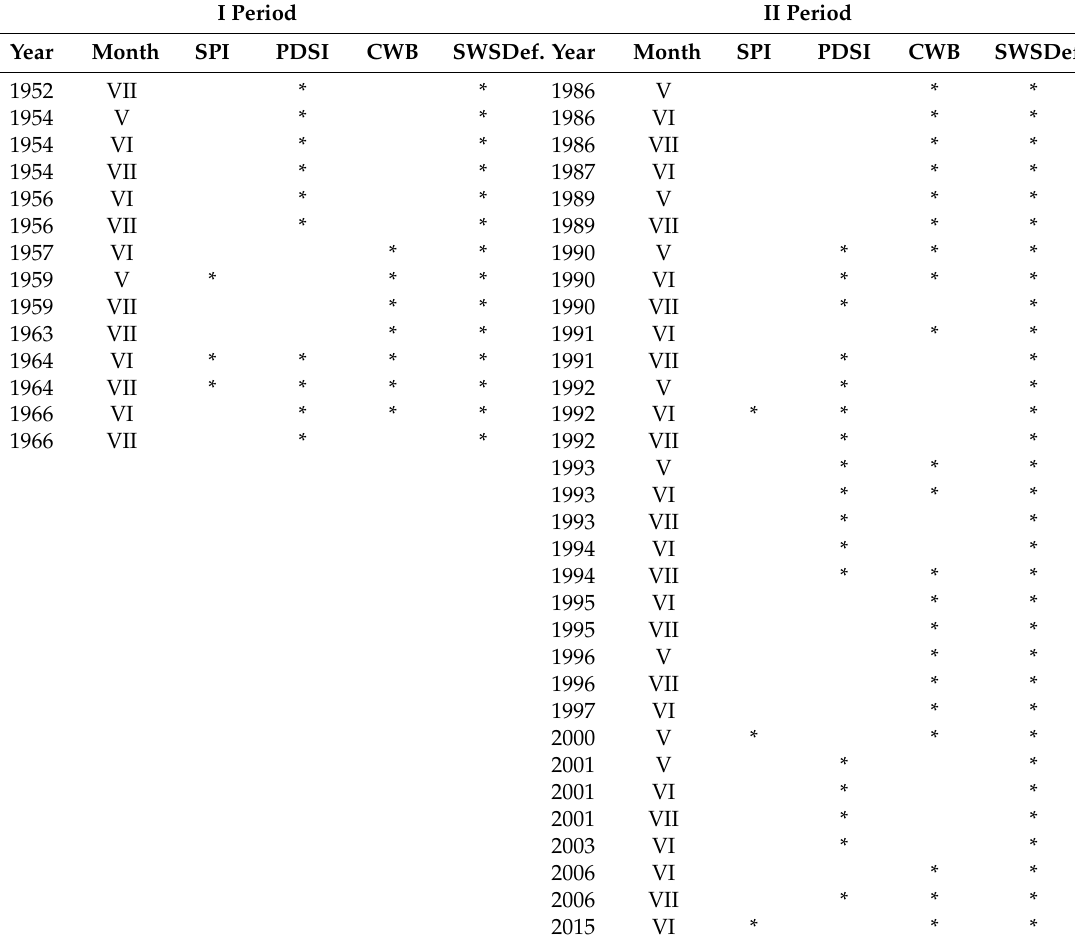
Table 2. Periods of drought indicated by at least two indices during the months of spruce growth during periods I and II. I